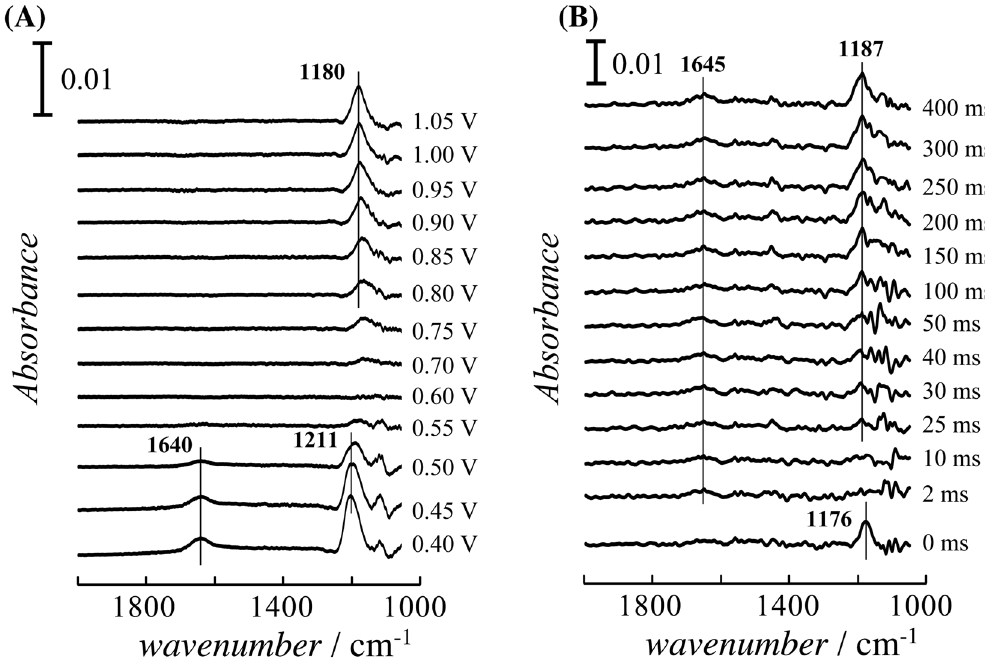
Figure 2. ( A ) Potential dependence of the SEIRAS of the quasi–Au(111) thin film on the Si prism in 0.5 M H 2 SO 4 + 1.0 mM CuSO 4 . ( B ) TRSEIRAS obtained by the step–scan method after the potential step from 1.05 V to 0.45 V with time resolution of 500 μ s. The reference spectra were corrected at 0.65 V vs SHE. The spectral resolutions of ( A ) and ( B ) were 4 cm − 1 and 8 cm − 1 ,